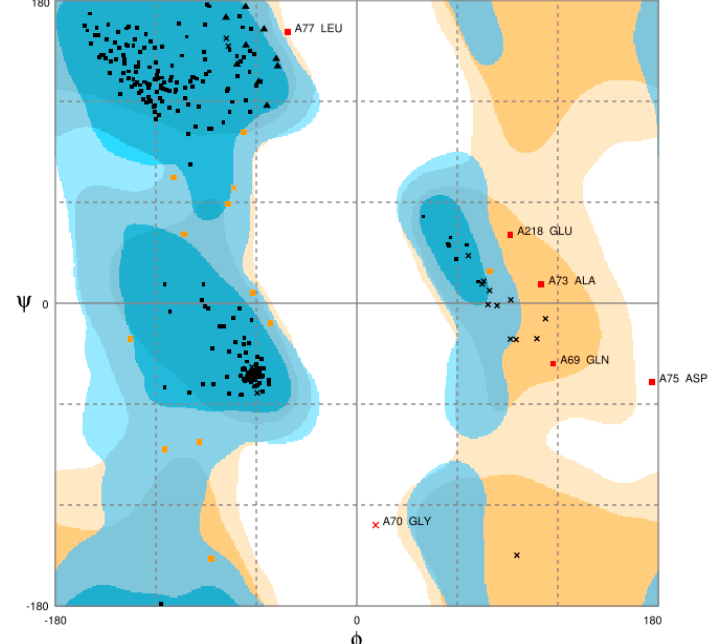
Figure 3. Ramachandran plot of the modelled MIC-A. The percentage of amino acid residues in the most favoured, allowed, and outlier regions are indicative of the quality of the modelled MIC-A protein structure.